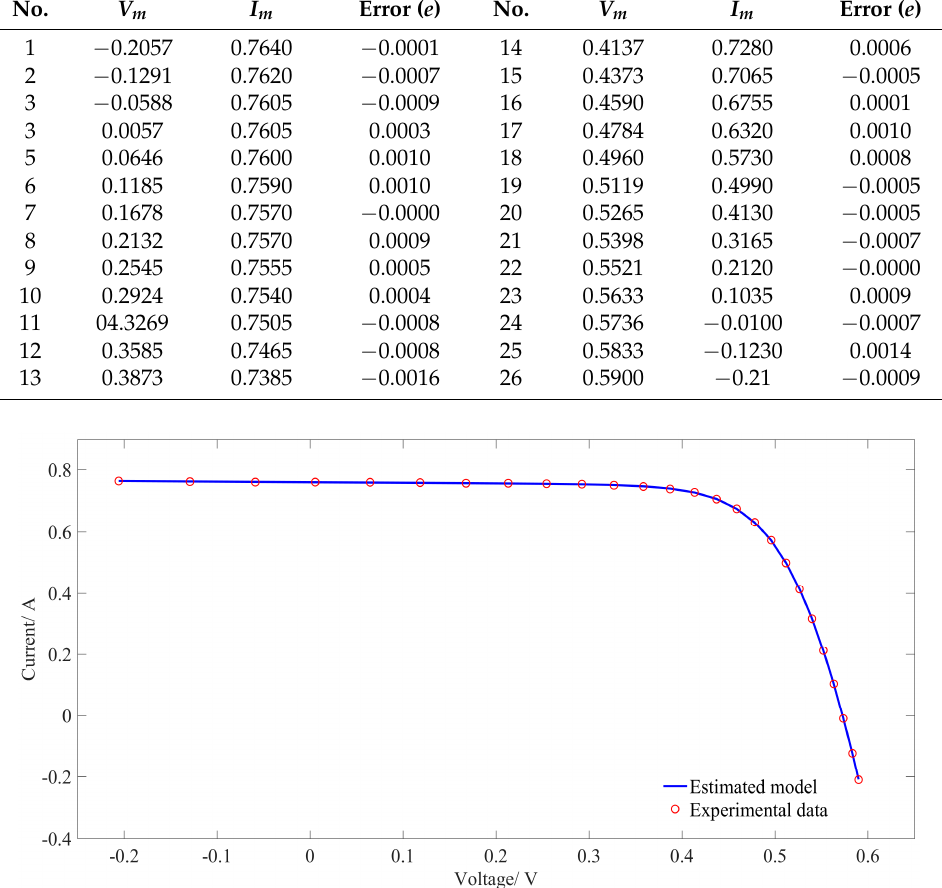
Figure 6. Comparison of estimated model and experimental data I-V characteristics of single diode model by the HPSOSA.